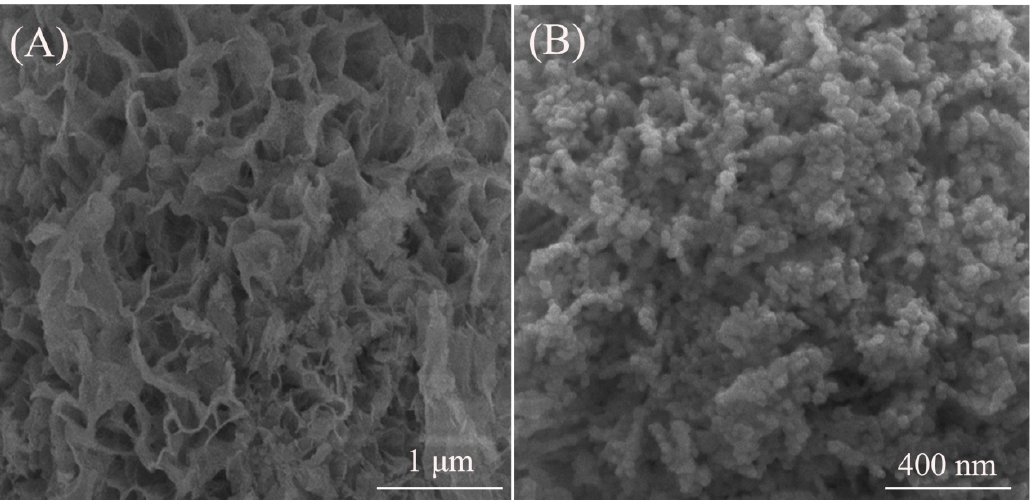
Figure 2. FE-SEM micrographs showing morphologies of the precipitation precursor ( A ) and its reduction product at 1000 °C ( B ).